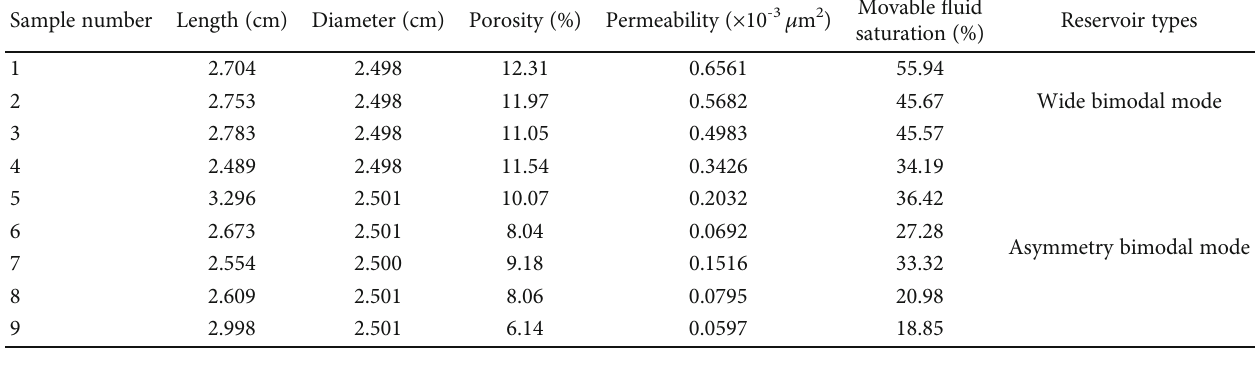
Table 1: Physical properties and dynamic fl uid saturation information of the sample.